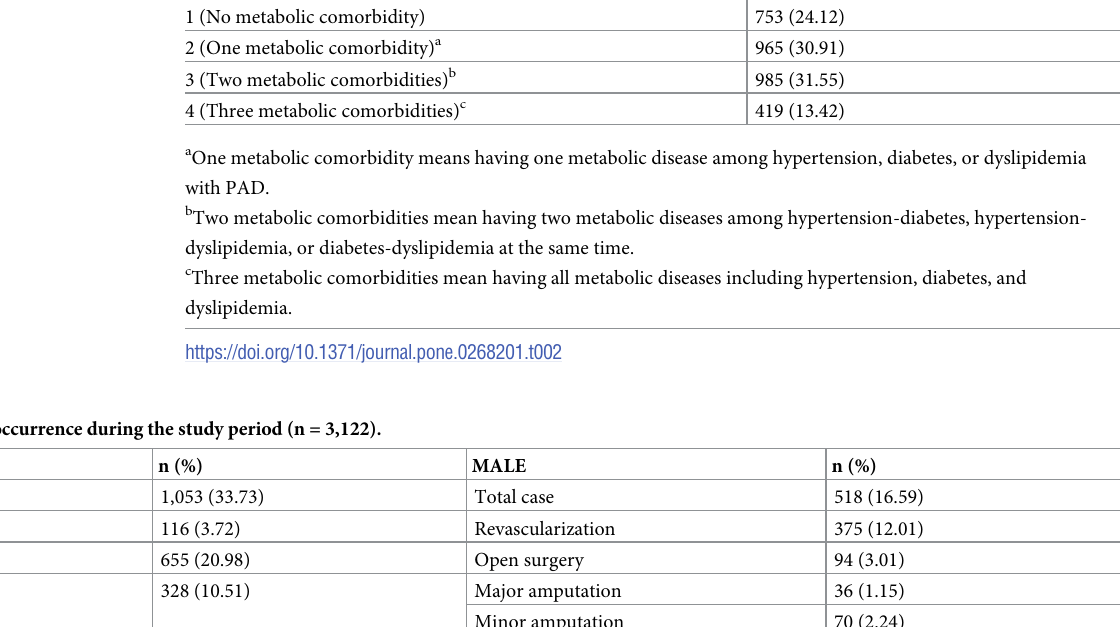
Kaplan-Meier survival curves demonstrated that PAD patients with more metabolic comor- bidities had a shorter MACE-free period (Fig 2). The risks of MACE associated with the num- ber of metabolic comorbidities were assessed in 3,122 old PAD patients (Table 4). Adjusted Cox proportional hazards analyses showed additive effects of multiple metabolic comorbidities on MACE. Old PAD patients with metabolic comorbidities had a greater risk of MACE than those without metabolic comorbidity. The adjusted hazard ratio (aHR) of the risk of MACE from having one metabolic comorbidity was 1.69 (95% confidence interval [CI]: 1.38–2.06; p < 0.0001). Having two metabolic comorbidities further increased the risk of MACE (aHR: